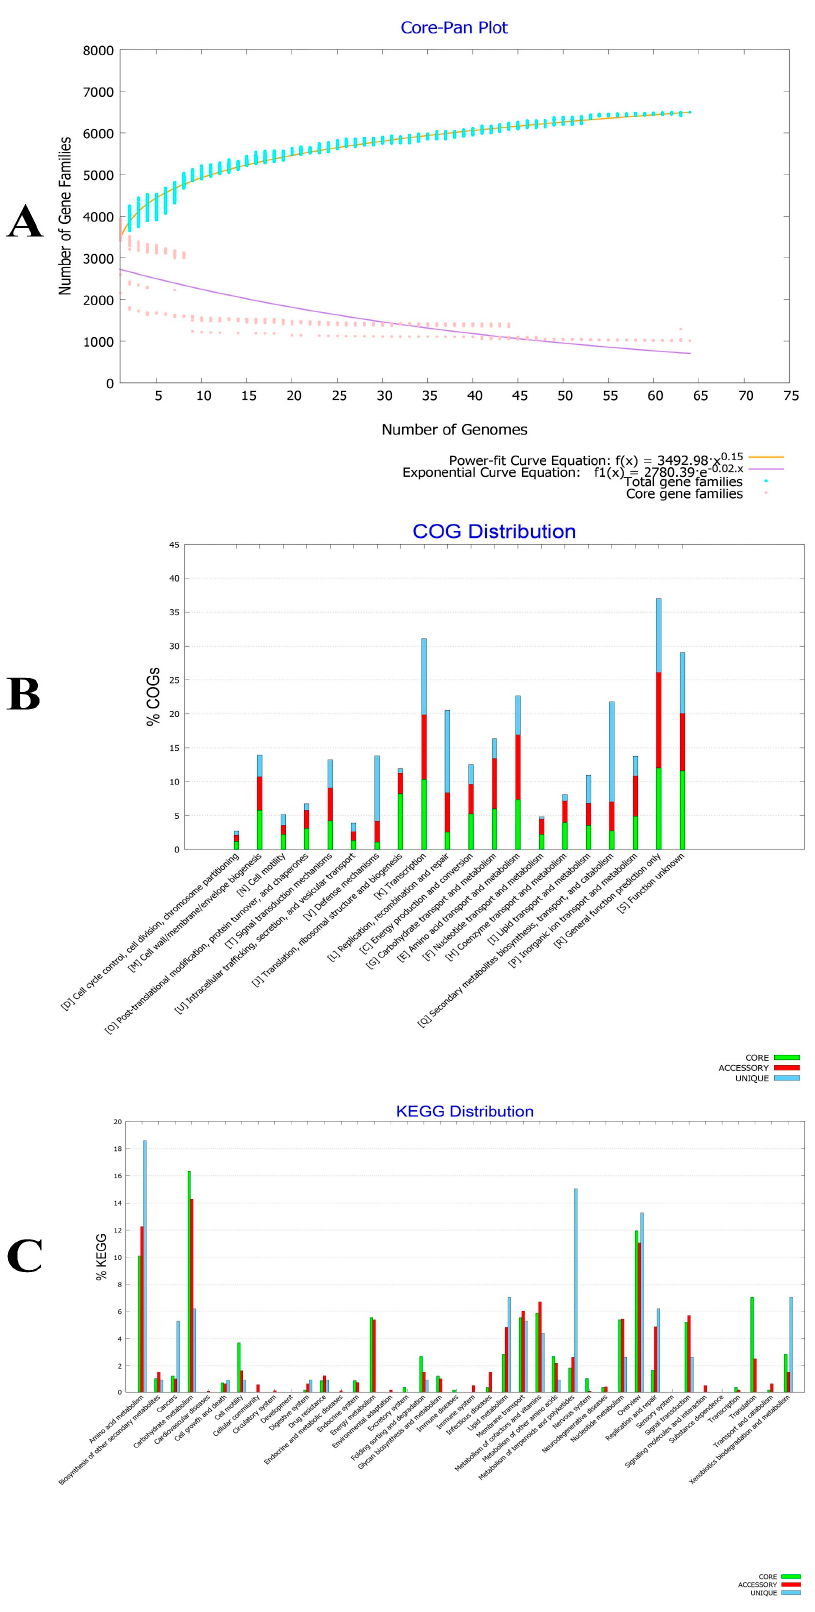
Figure 3. ( A ) Core-Pan genome plot of B. velezensis isolates based on the number of genomes and number of gene families; ( B ) COG; and ( C ) KEGG distribution among core, accessory and unique genomes of B. velezensis isolates.